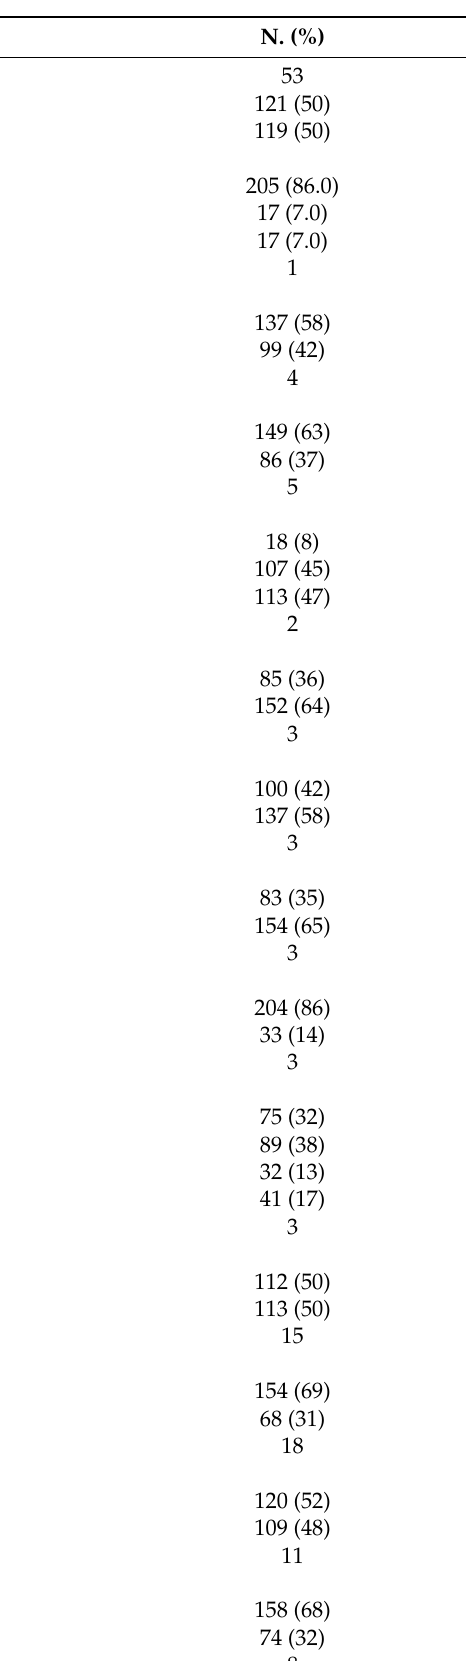
Table 1. Tumor characteristics of 240 invasive breast cancer